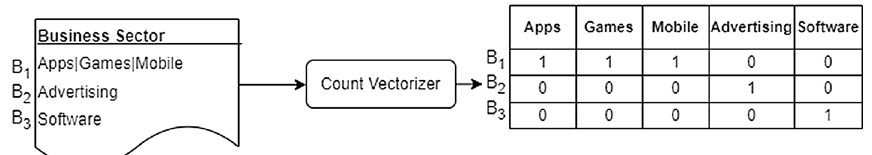
Fig. 10 Examples of creating business sector feature using Count Vectorizer technique. Each business B i has a list of “Business Sector” tags in the dataset (left). The Count Vectorizer represents each business B i as one-hot (0/1) features, depending on whether a business has a specific “Business Sector” tag or not